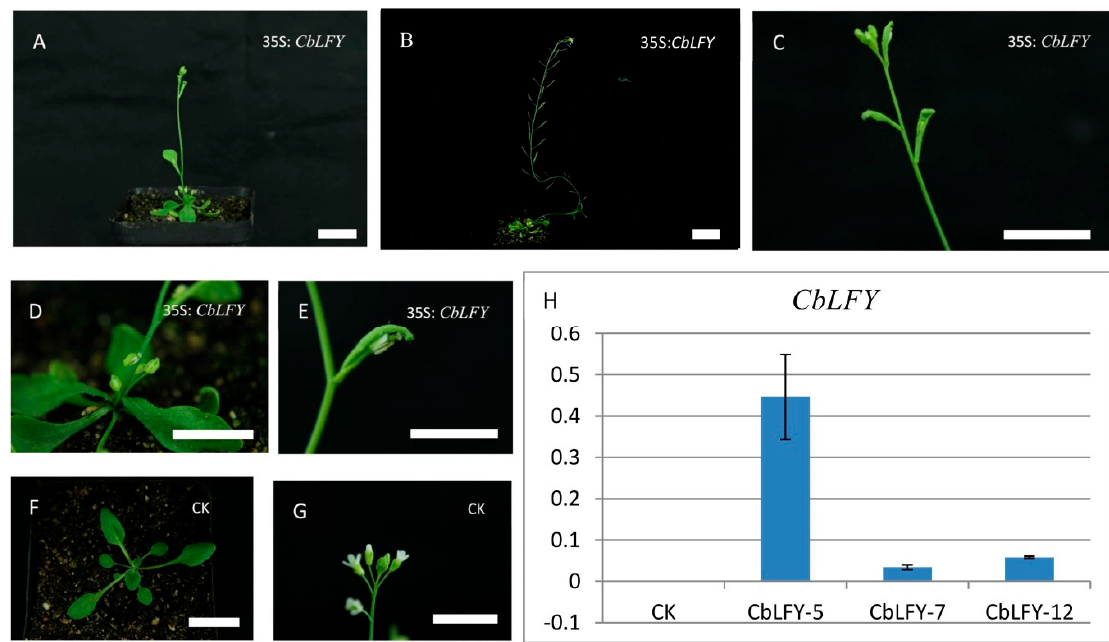
Figure 9. Phenotypes of 35S:CbLFY transgenic Arabidopsis T 2 lines and expression analysis of the